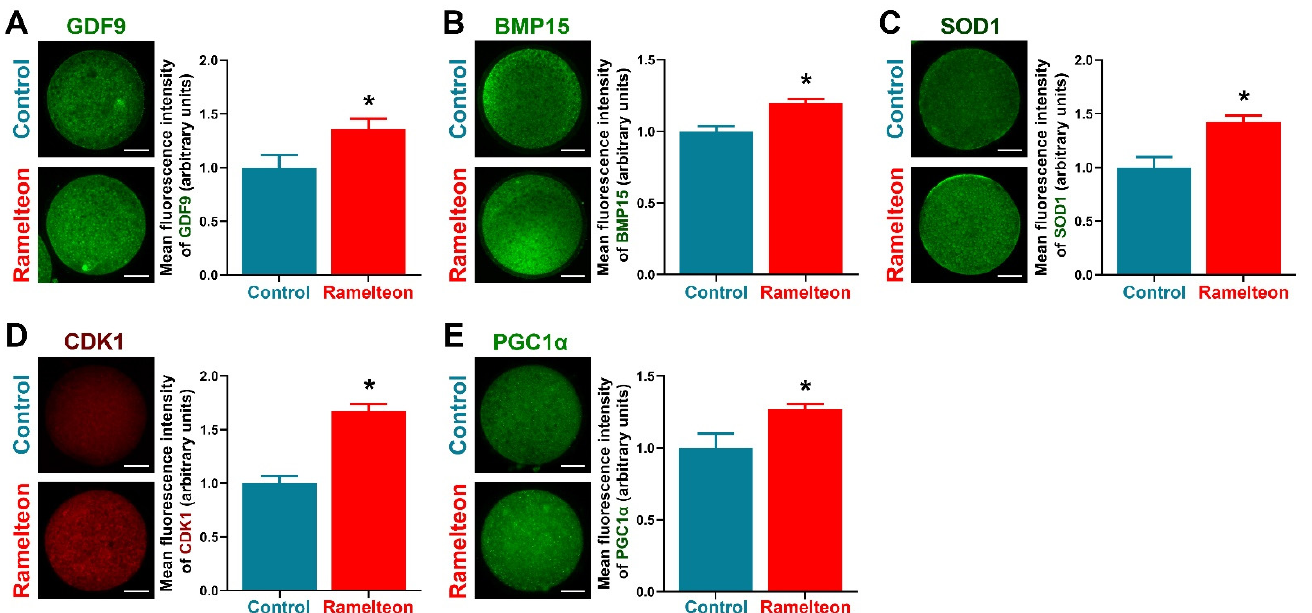
Figure 5. The protein levels were analyzed by immunocytochemistry in porcine oocytes. Expression of ( A ) GDF9; ( B ) BMP15; ( C ) SOD1; ( D ) CDK1; ( E ) PGC1 α in oocytes, respectively. Within the same protein, bars with an asterisk are significantly different ( p < 0.05). Results are shown as the average ± SEM of at least three repeats of independent experiments. Ramelteon concentration is 10 − 11 M. Scale bars = 40 µM.